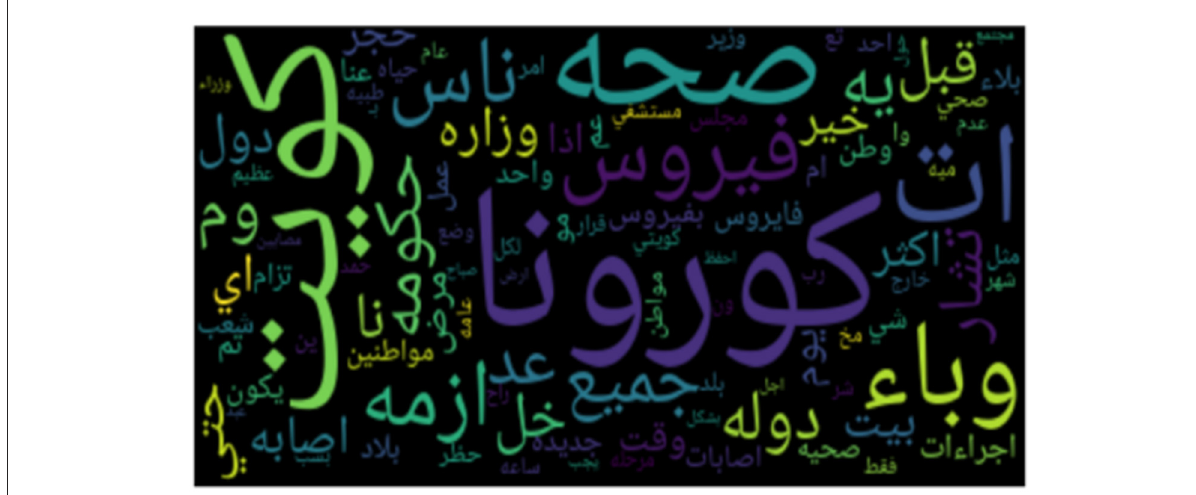
FIGURE7 Word cloud of tweets from Kuwait.